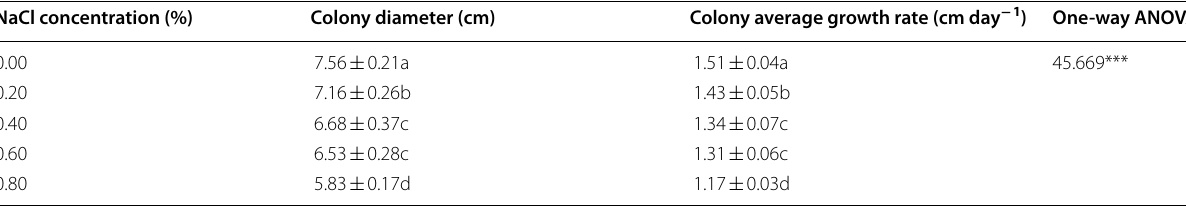
Data are presented as mean of at least six replicates standard deviation. Small letters in the same column show statistically significant differences among different ± NaCl-induced salt stress treatments for the same parameter at P